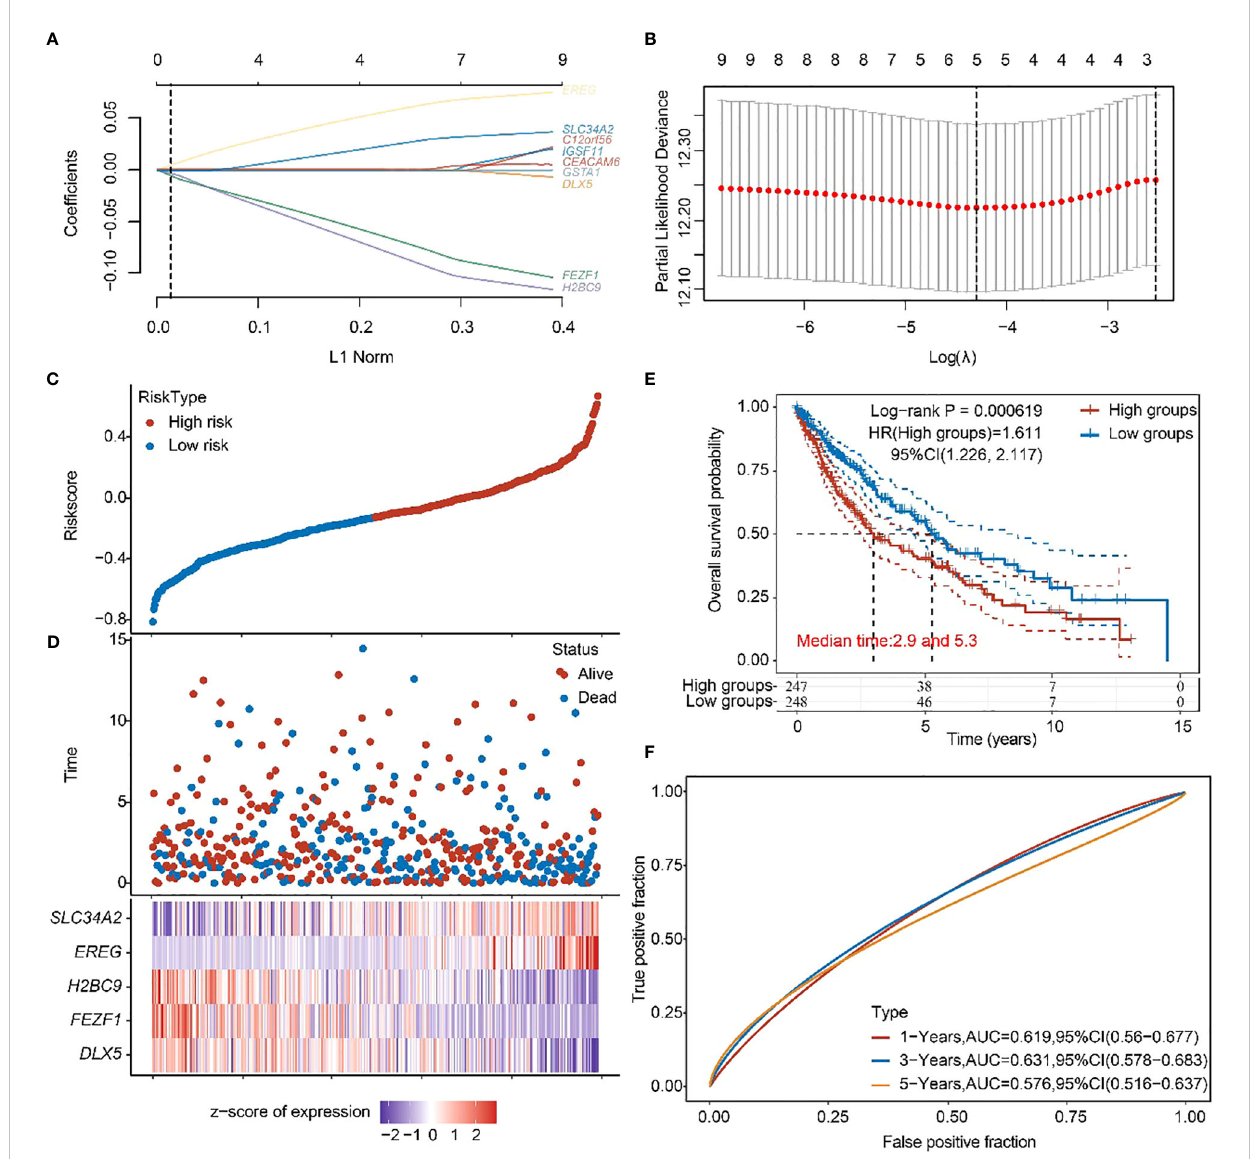
FIGURE 5 Construction of prognostic features of TTN mutation DEGs in LUSC. (A, B) Distribution of LASSO coef fi cients of DEGs to obtain the adjustment parameter. l .min = 0.0329, the vertical black dashed line in B de fi nes the optimal l value. (C) Distribution of risk score of TTN mutation in LUSC. (D) Survival status and duration of TTN mutation in LUSC patients. (E) KM survival curves for high- and low-risk groups. (F) 1-year, 3-year, and 5-year ROC